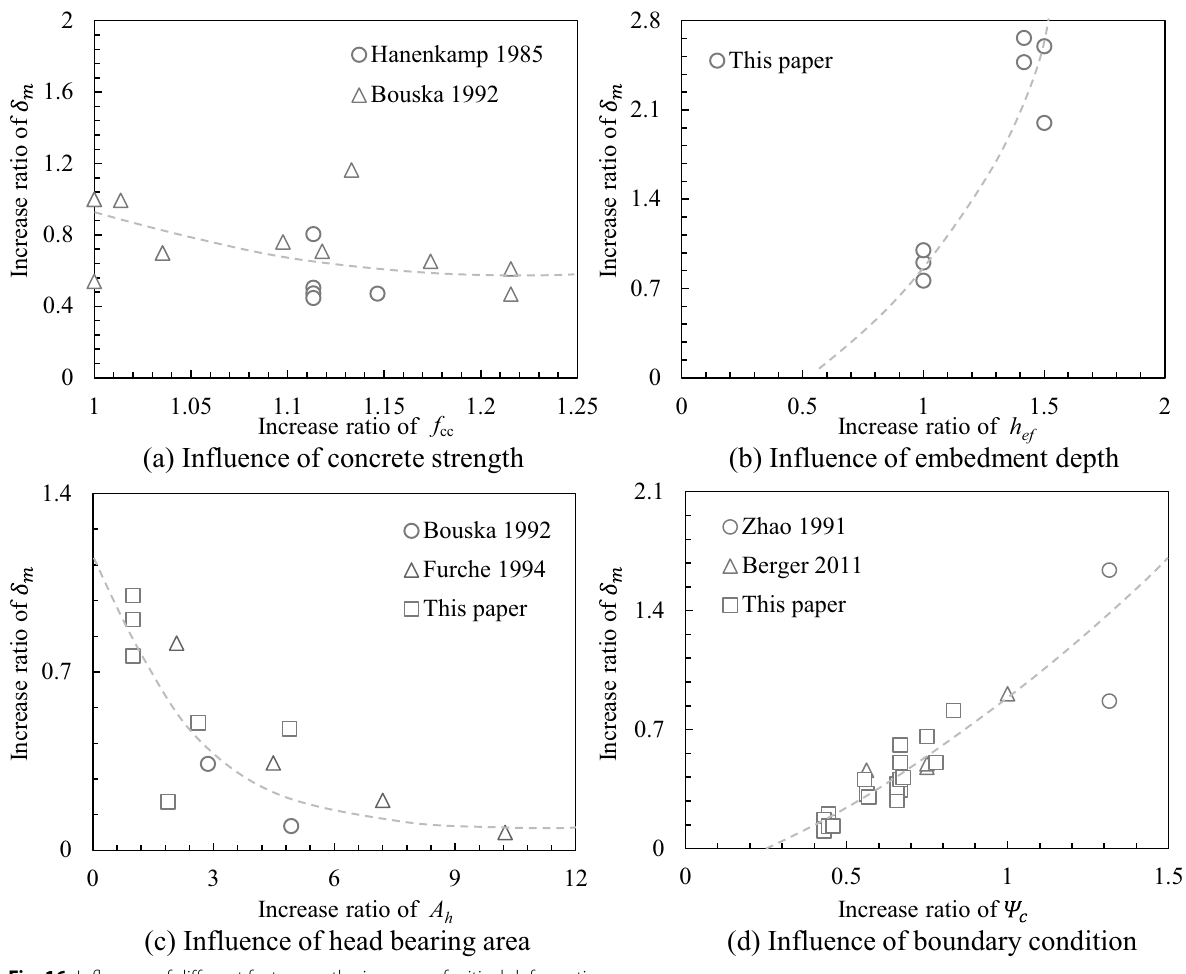
Fig. 16 Influence of different factors on the increase of critical deformation.